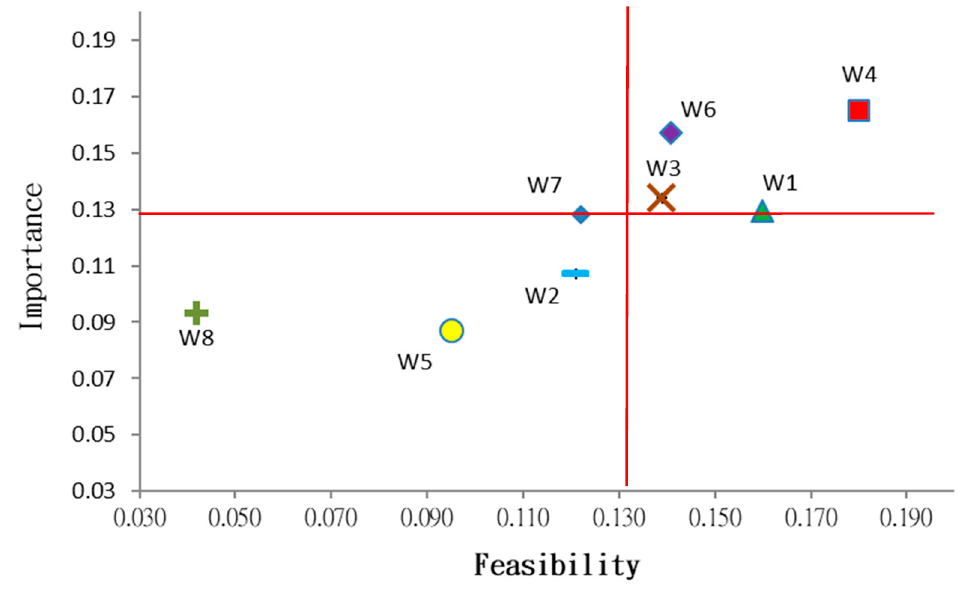
Figure 4. Diagram of the Significance and Feasibility of Ability Indices.